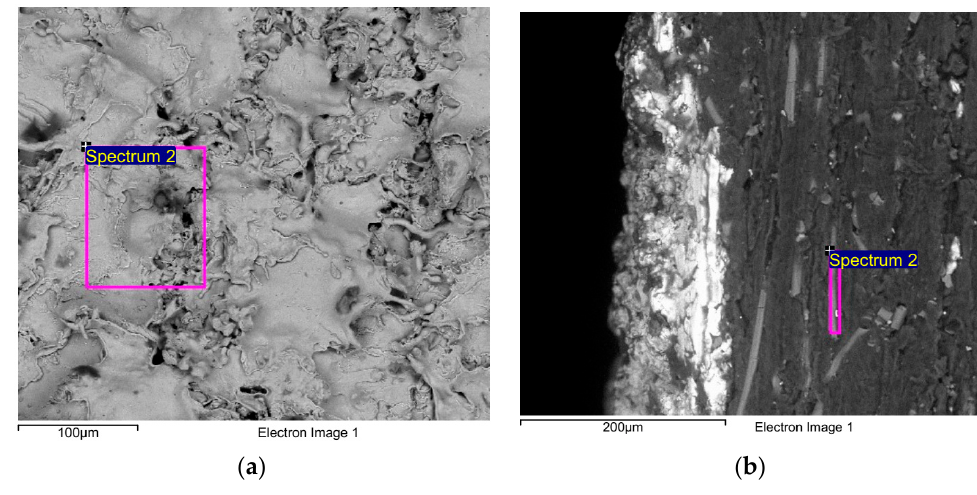
Figure 3. EDAX analysis: ( a ) zinc; ( b ) PPS materials.